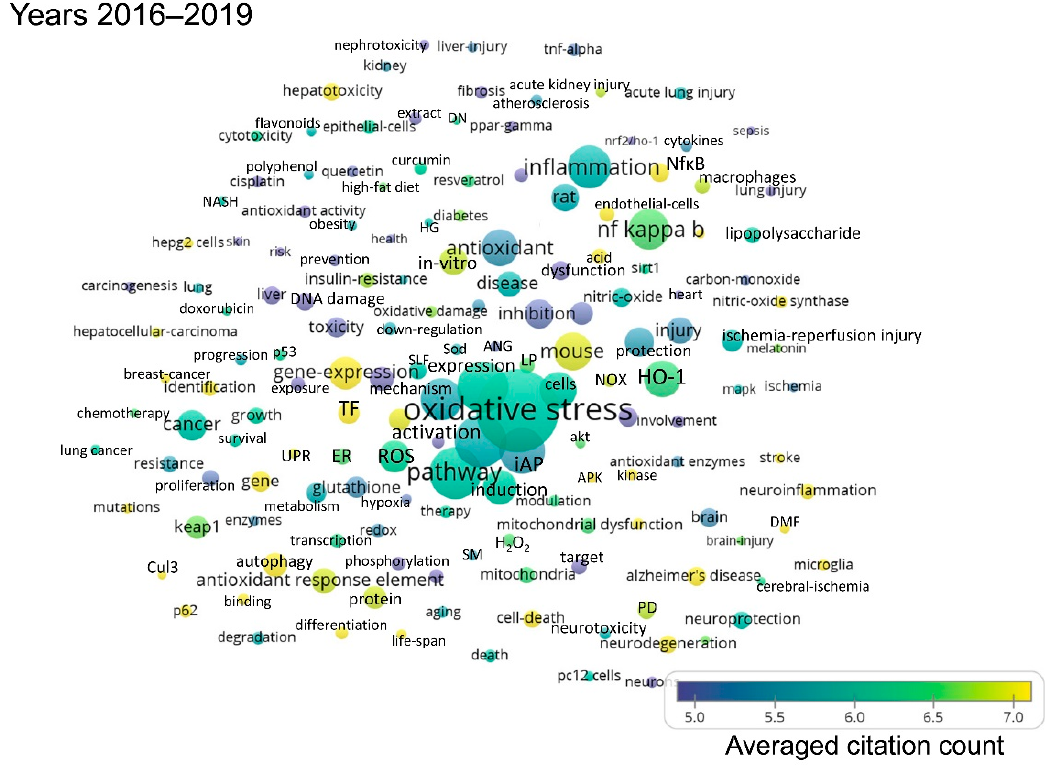
Figure 5. Term map for years 2016–2019. Bubble map showing the visualization of 140 terms that appeared in at least 50 publications published between 2016 and July 2019. For explanations on bubble size, color and proximity, see the legend of Figure 2. All the terms visualized are listed in Table S4, along with their respective occurrence frequencies and averaged citations. ANG: Angiogenesis, APK: